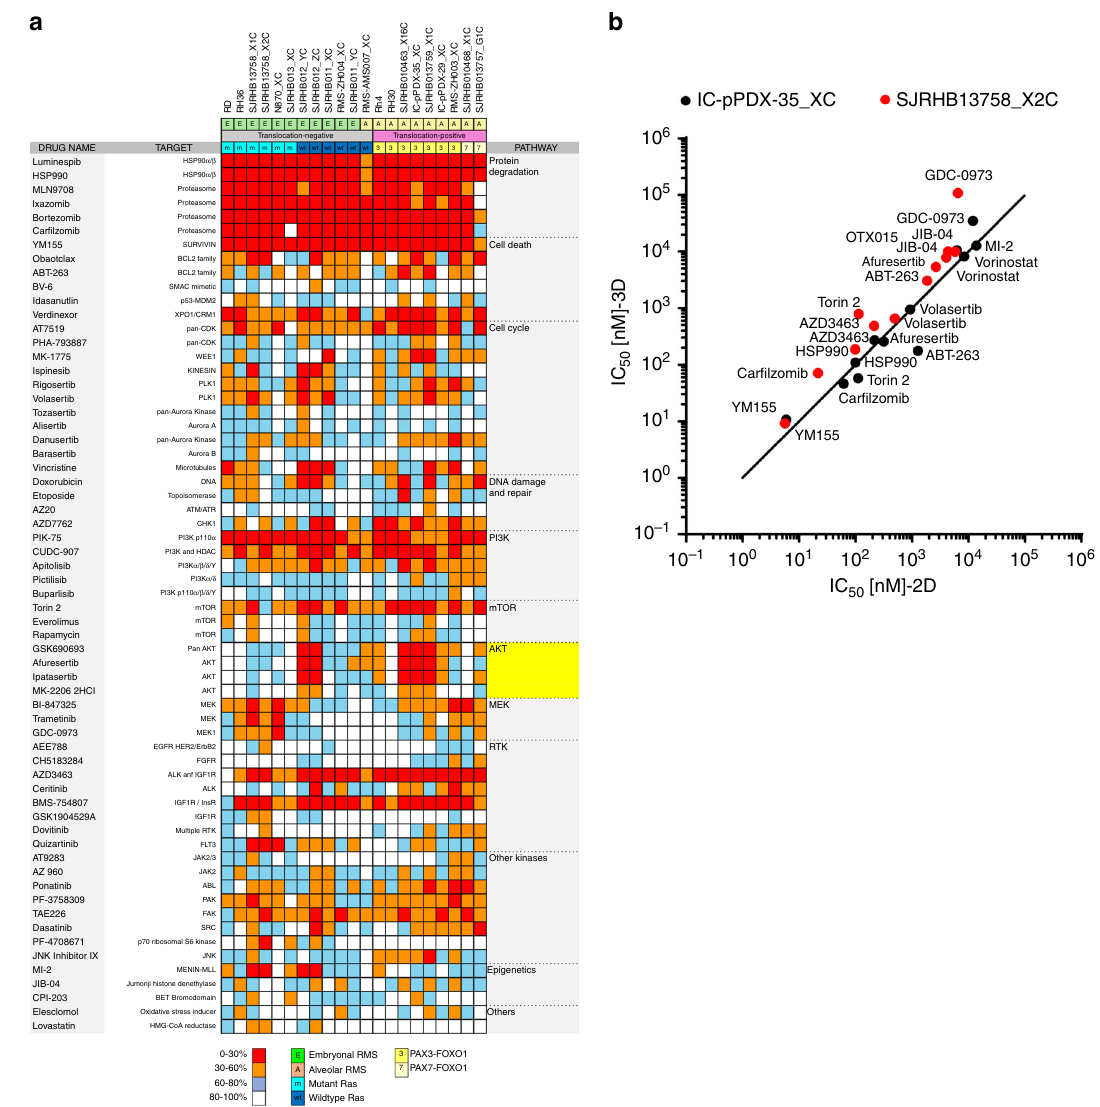
Fig. 4 2D and 3D in vitro drug pro fi ling of PPCs. a Heat map depicting the activity of indicated agents used at a fi nal concentration of 500 nM across the panel of RMS cells. Histological subtype, fusion status and RAS mutation status are shown above each column. Each color in the heat map indicates the percentage of remaining cell viability after treatment relative to vehicle control: 0 – 30% (red), 30 – 60% (orange), 60 – 79% (light blue) and >79% (white) (Mean; n = 2 biological replicates). b Correlation plot comparing IC 50 values for indicated drugs determined in 2D and 3D cultures of IC-pPDX-35 and SJRHB13758_X2C cells. (Mean; n = 2 – 3 biological replicates). Source data are provided as source data fi (SJRHB13758_X2C) up to 30 percent of the cells differentiated (Supplementary Fig. 10B, C). IC 50 of the most sensitive cases (IC 50 < 10 nM) were in the range of therapeutically applicable concentrations. The same was the case for afuresertib (IC 50 < 281 nM) and a second AKT inhibitor (GSK690693) for the most sensitive PPCs (Fig. 6d). Western blot analysis in sensitive (IC- pPDX-35_XC) and resistant (RMS-ZH004_XC) cases con fi rmed that afuresertib selectively inhibited phosphorylation of S6 Ribosomal Protein and released a negative feedback loop on AKT phosphorylation similar to previous reports 17 (Fig. 6e and